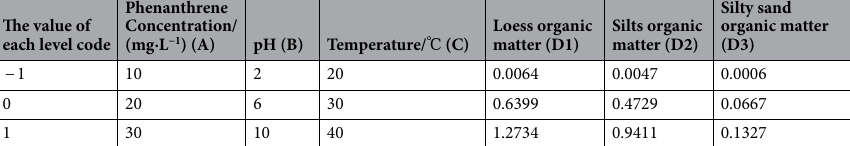
Table 2. Values of experimental factors for different types of soil adsorption and desorption systems.